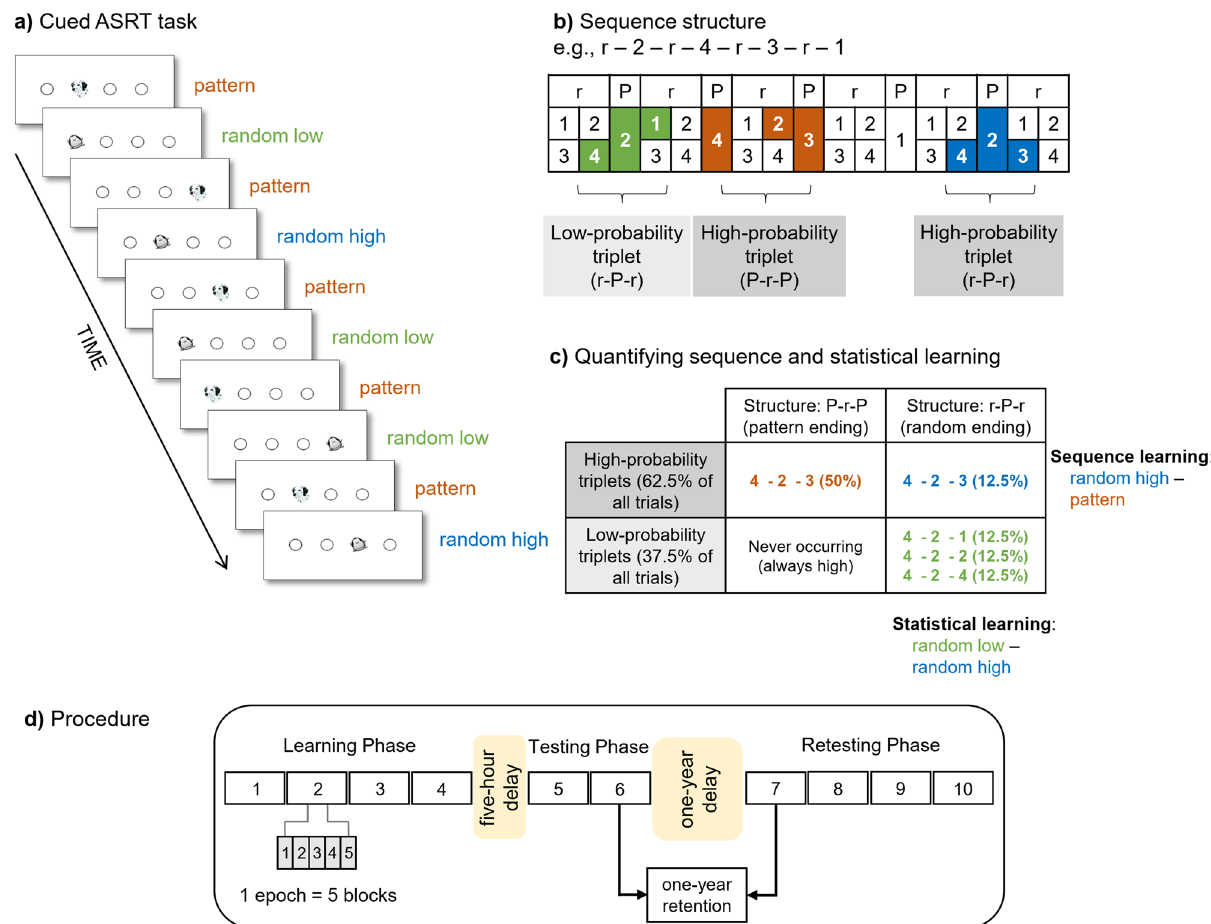
Figure 1. The cued Alternating Serial Reaction Time (ASRT) task and experimental procedure. ( a ) Pattern and random trials were presented in an alternating fashion. Pattern trials were marked by a picture of a dog’s head, and random trials were marked by a picture of a penguin. ( b ) An example of the sequence structure. Numbers indicate pattern trials, and ‘r’ indicates a randomly selected location out of the four possible ones. The alternating sequence makes some runs of three consecutive trials (labeled as triplets) more probable than others, called high-probability and low-probability triplets, respectively. Among high-probability triplets, the last element of the triplet can be either pattern or random. Based on this, we could determine pattern triplets that are always of high probability (orange shading in panel B and orange font in panel C) and random high-probability triplets (blue shading in panel B and blue font in panel C). Among low-probability triplets, only random low-probability triplets can occur (green shading in panel B and green font in panel C). ( c ) The underlying learning processes measured by the task. Statistical learning is calculated by contrasting the accuracies or RTs on the random high and random low trials (blue vs. green, the right column of the table). Sequence learning is quantified by contrasting the accuracies or RTs on the pattern and random high trials (orange vs. blue, the top row of the table). The table presents the calculation of learning processes on RT data. ( d ) The design of the experiment. The experiment was composed of three sessions. The Learning Phase consisted of four epochs (one epoch contained 5 blocks, and each block consisted of 85 stimuli), followed by a 5-h offline period then the two- epoch-long Testing Phase on the same day. The Retesting Phase with four epochs was administered ca. one year later. Figure 1A, 1B, and 1C are adapted from Nemeth, et al. 21, Fig. 1D is adapted from Kóbor, et al.